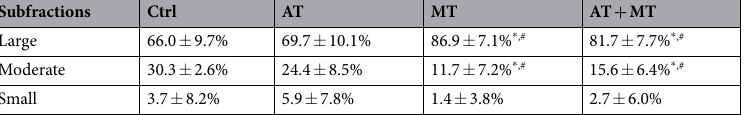
Table1. HDL subfractions at 10 weeks after administration. Percentage of HDL subfractions at 10 weeks after administration is expressed as mean ± SD. * P < 0.05 compared with Ctrl group; # P < 0.05, compared with AT group. Ctrl, control group; AT, atorvastatin group; MT, metformin group; AT + MT group, atorvastatin/ metformin combination therapy